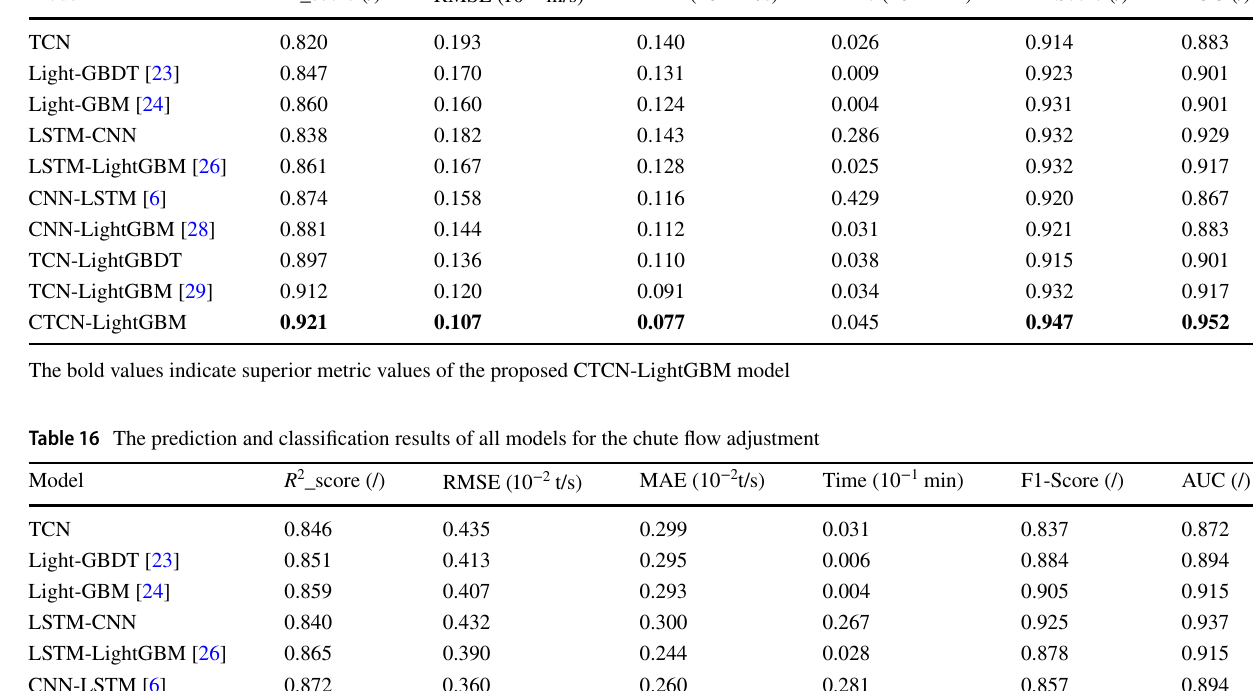
Table 15 The prediction and classification results of all models for the truck speed adjustment